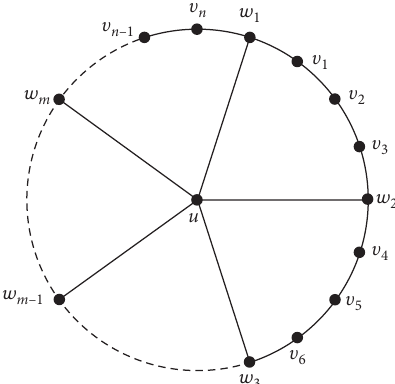
Figure 1: The Jahangir graph J